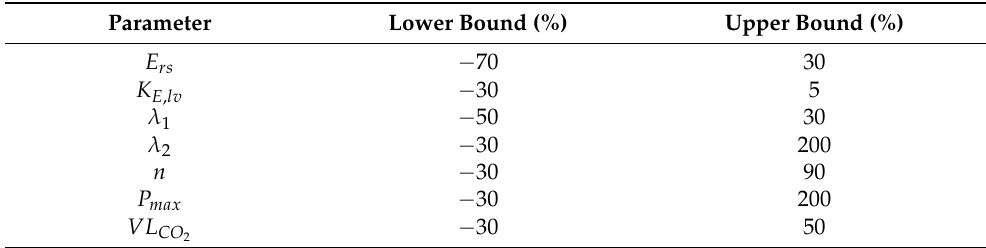
Table 4. Evaluation ranges of parameters according to the variations and constraints